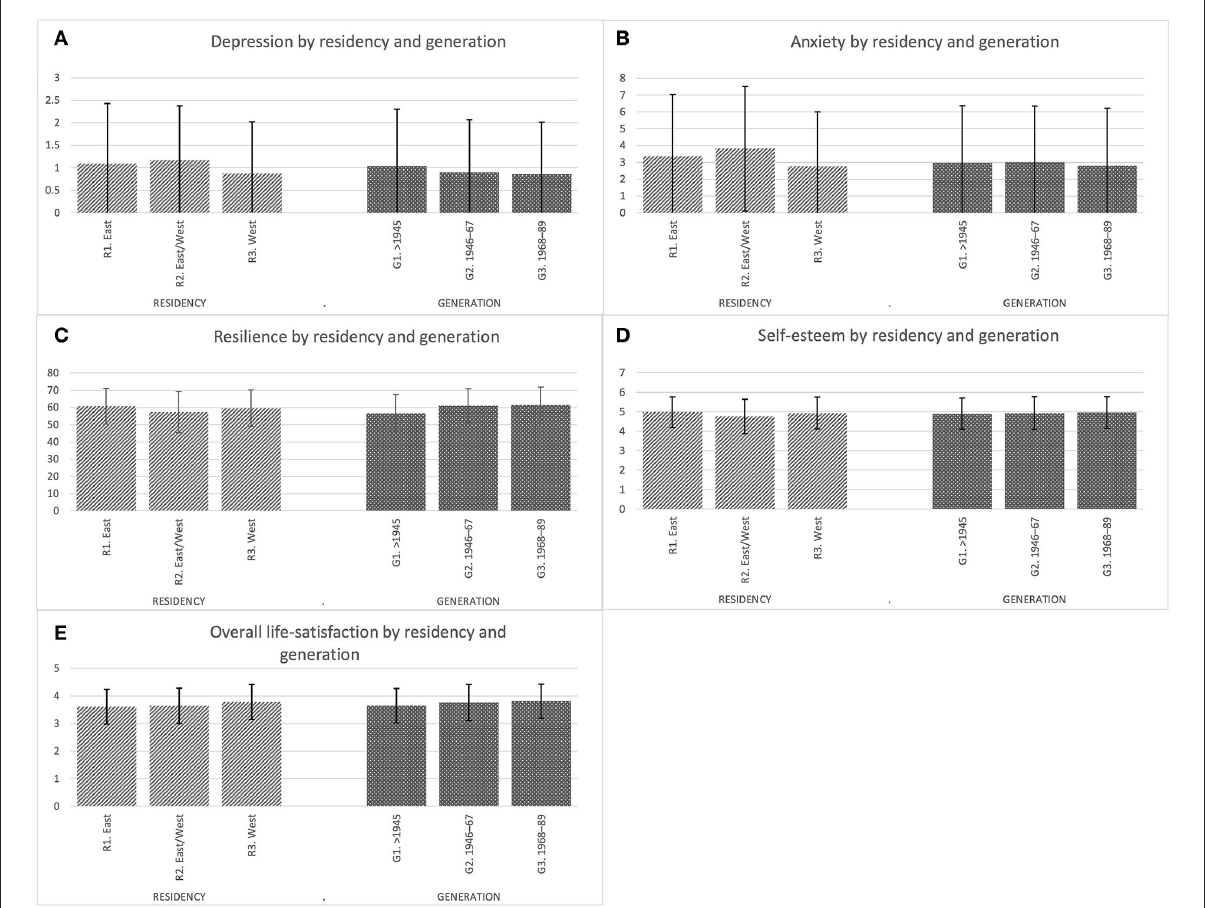
FIGURE1 (A) Depression by residency and generation. (B) Anxiety by residency and generation. (C) Resilience by residency and generation. (D) Self-esteem by residency and generation. (E) Overall life-satisfaction by residency and generation. Presented are means and SDs. ANOVA (Scheffe-tests with p < 0.05 in parentheses for all groups). M, male; F, female; R, residency; G, generation. (A) N = 4,517. (1) Sex F (l / 4,499) = 12.53; p < 0.001; (2) Residency F (2 / 4,499) = 17.98; p < 0.001 (R1, R2 > R3); (3) Generation F (2 / 4,499) = 9.00; p < 0.001 (G2, G3 > G1); (4) Sex*Generation F (2 / 4,499) = 9.15; p < 0.001. (B) N = 4,537. (1) Sex F (l / 4,519) = 27.22; p < 0.001; (2) Residency F (2 / 4,519) = 21.75; p < 0.001 (R1, R2 > R3); (3) Generation F (2 / 4,519)